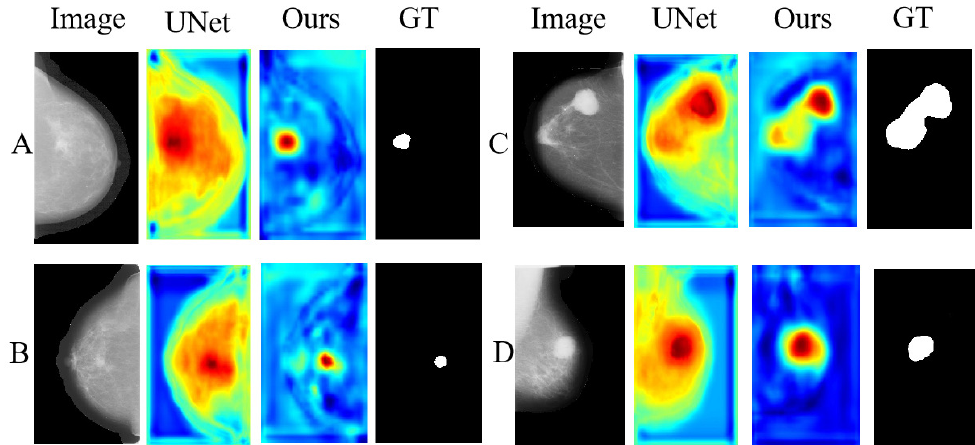
Figure 3. Heatmaps of breast cancer segmentation achieved by the proposed framework, the compar- ative method and the ground truth results. ( A – D ) refer to Breast-A, Breast-B, Breast-C and Breast-D datasets,